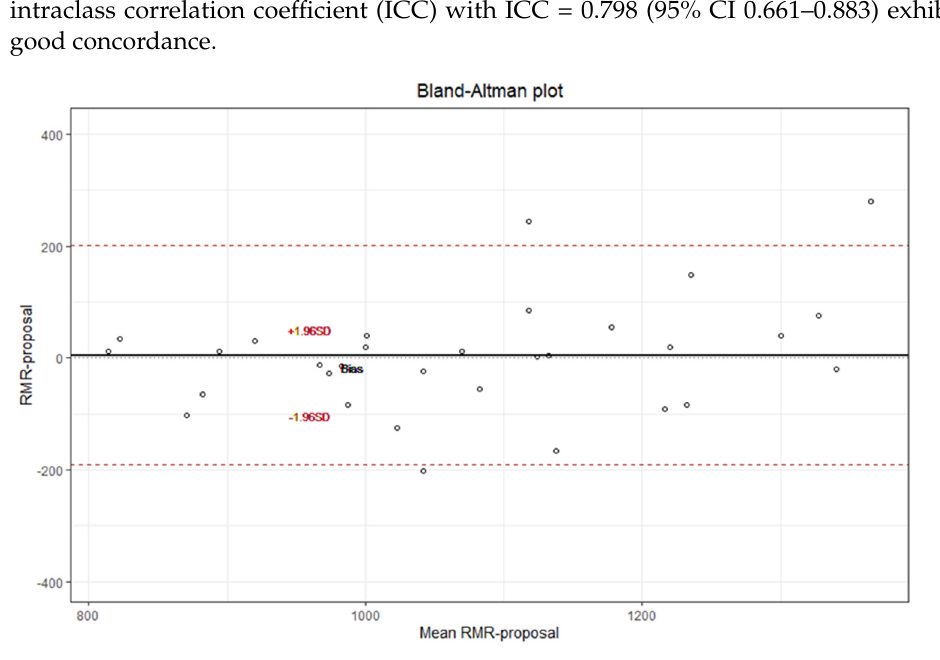
Figure 2. Consistency between the RMR estimated by the proposed equation versus the RMR IC according to the Bland and Altman method. according to the Bland and Altman